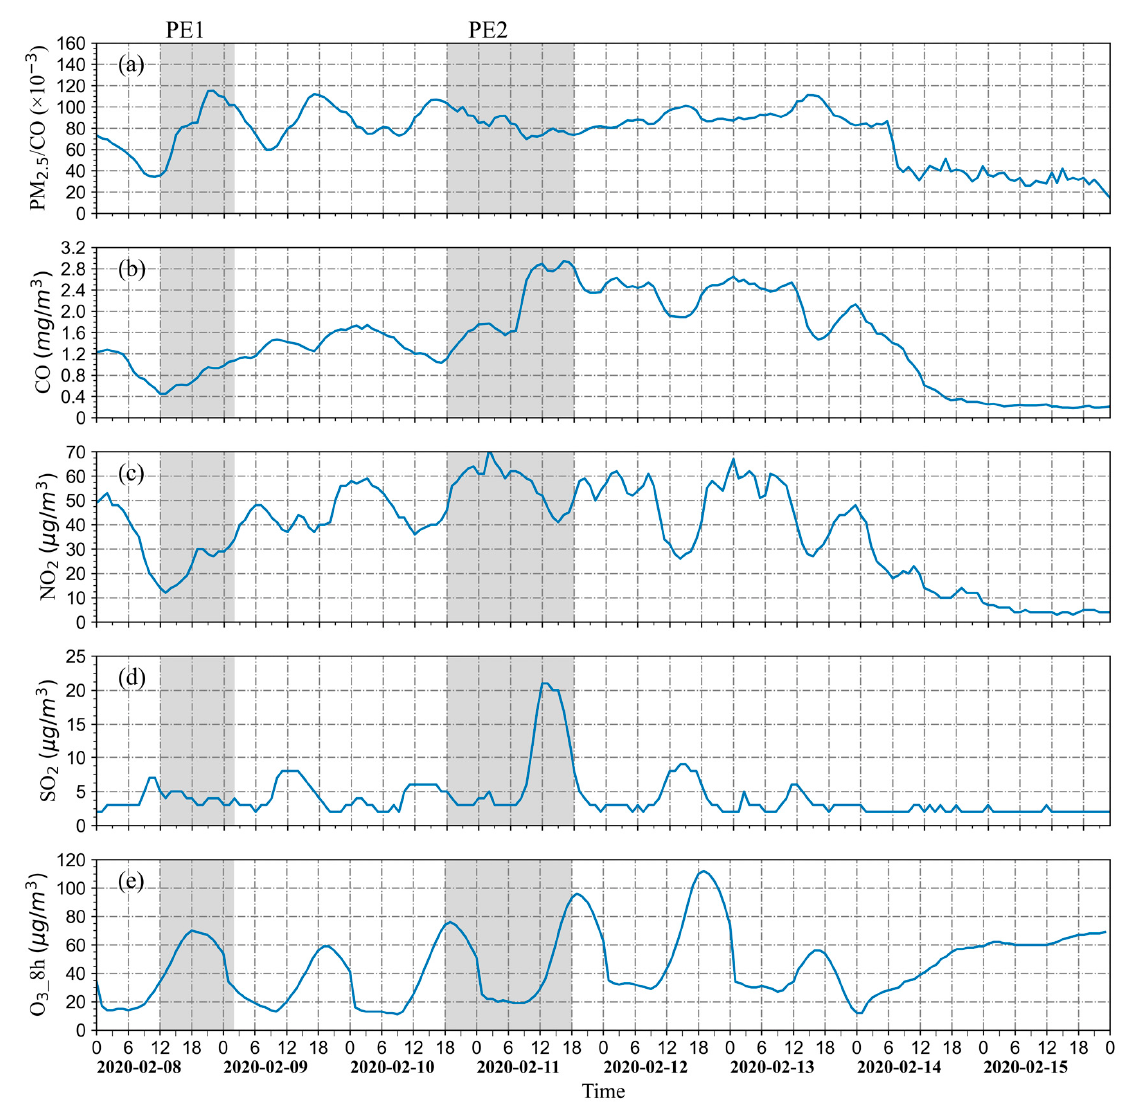
Figure 10. Changes in the mass concentrations of near-surface pollutants in Beijing from 8 to 15 February 2020. ( a ) PM 2.5 /CO, ( b ) CO, ( c ) NO 2 , ( d ) SO 2 and ( e ) O 3 (the ozone concentrations are 8-h sliding averages).